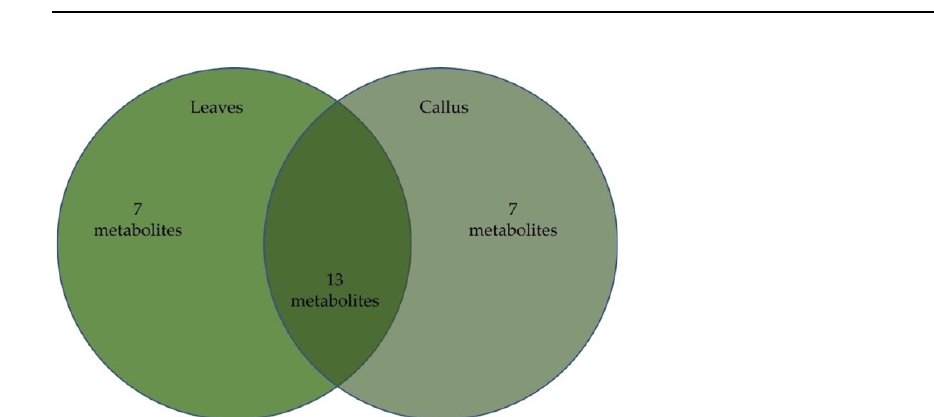
Figure 4. Venn diagram presenting differences and similarities in metabolite content of oregano leaves and leaf-derived calluses. Table 2. Volatile extract analyses. Compounds are listed in order of elution from an HP-5MS column (RI = Kovats Indices calculated against C8 to C24 n-alkanes on the HP-5MS column). a = RI comparison, b = MS comparison, c = authentic sample comparison. nd: not detected